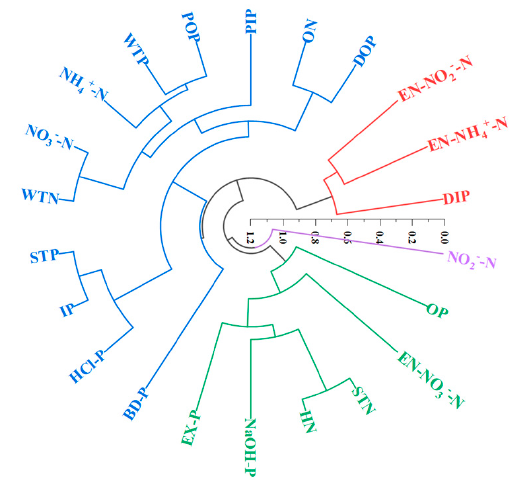
Figure 11. Cluster analysis of N and P in the study area (Different colors represent different classification results).